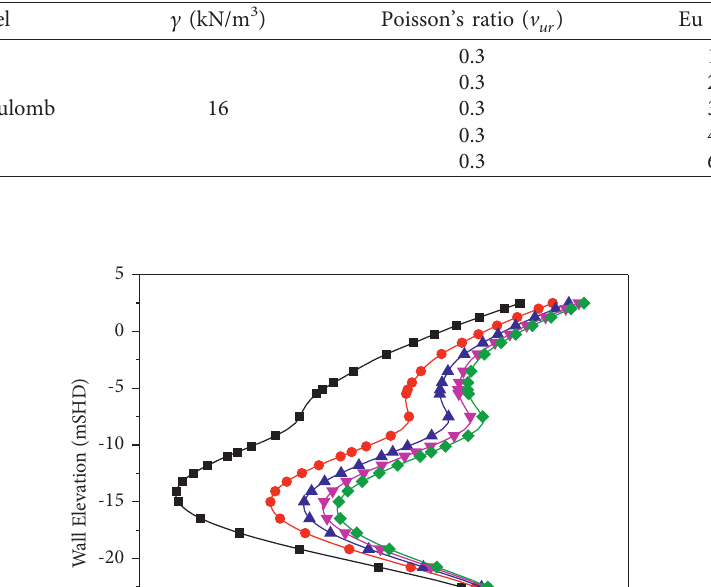
Table 3: Ground improvement layer parameters.